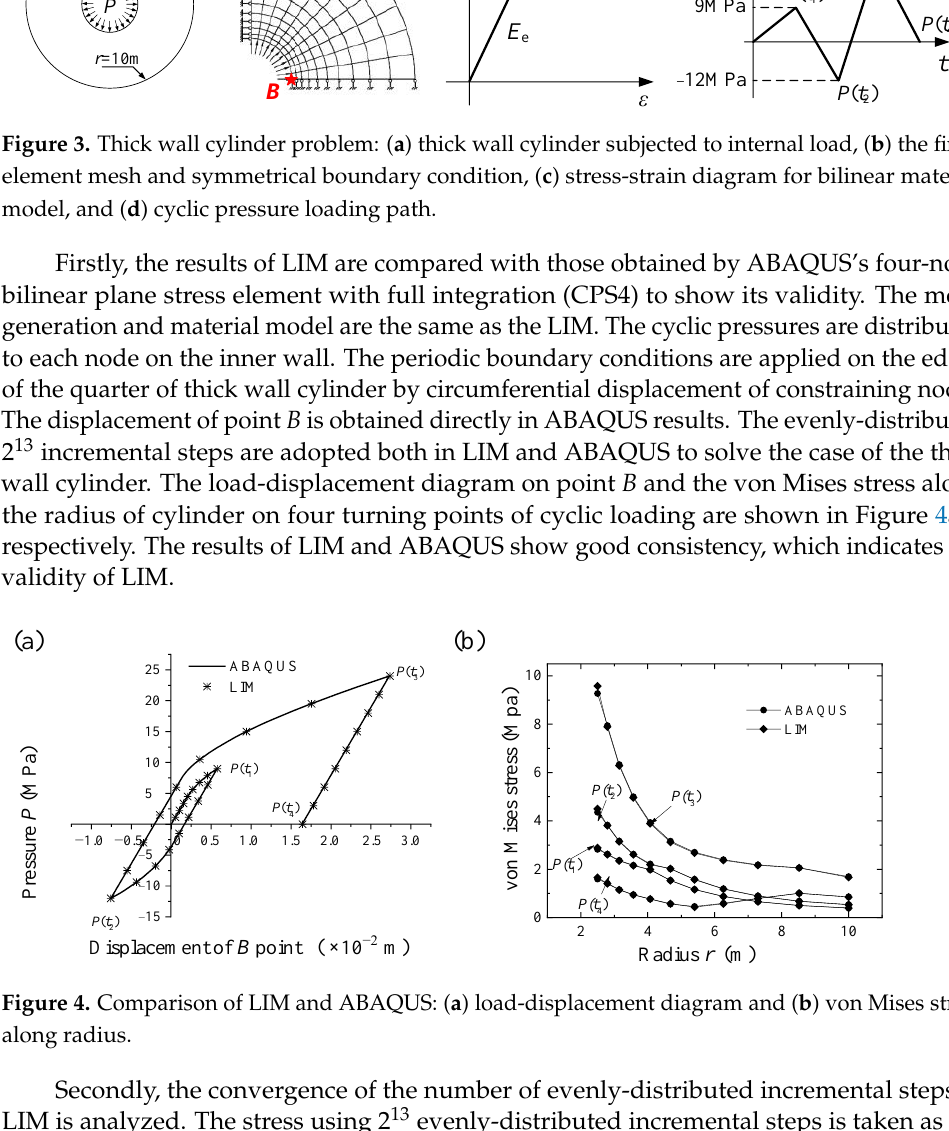
Figure 5. Convergence analysis of the number of incremental steps on four turning points of cyclic loading: ( a ) P ( t 1 ), ( b ) P ( t 2 ), ( c ) P ( t 3 ), and ( d ) P ( t 4 ).